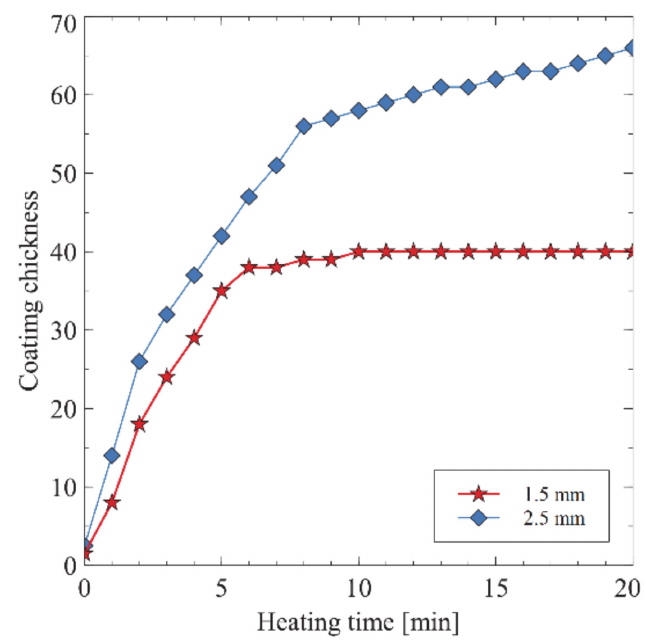
Figure 16. Curve of coating thickness with heating